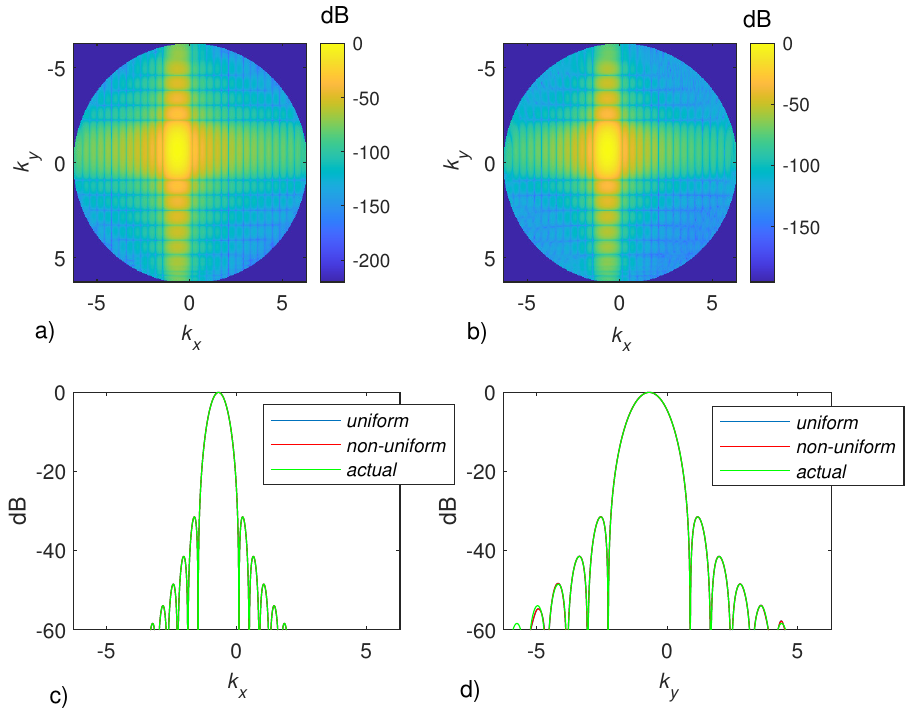
Figure 4. Normalized amplitude of the radiation pattern of J 1 ( x , y ) with X s = 8 λ , Y s = 4 λ , z o = 7 λ , X 0 = 30 λ and Y 0 = 15 λ . In ( a ), the radiation pattern is obtained by employing the near-field data according to the proposed non-uniform sampling scheme over the grid shown in panel ( b ) of Figure 2 and then interpolated over a λ /2 grid. In ( b ), the radiation pattern is obtained by directly employing the near-field data over a uniform λ /2 grid. Panels ( c , d ) have been obtained by fixing k y = k sin ( π /20 ) sin ( π /4 ) and k x = k sin ( π /20 ) cos ( π /4 ) , respectively, and compare the radiation pattern cut-views passing through the main-beam maximum. The green lines refer to the actual radiation pattern, the blue lines to the radiation pattern computed by using the uniform λ /2 sampling and the red ones show the radiation pattern obtained by the proposed method. Noiseless case.